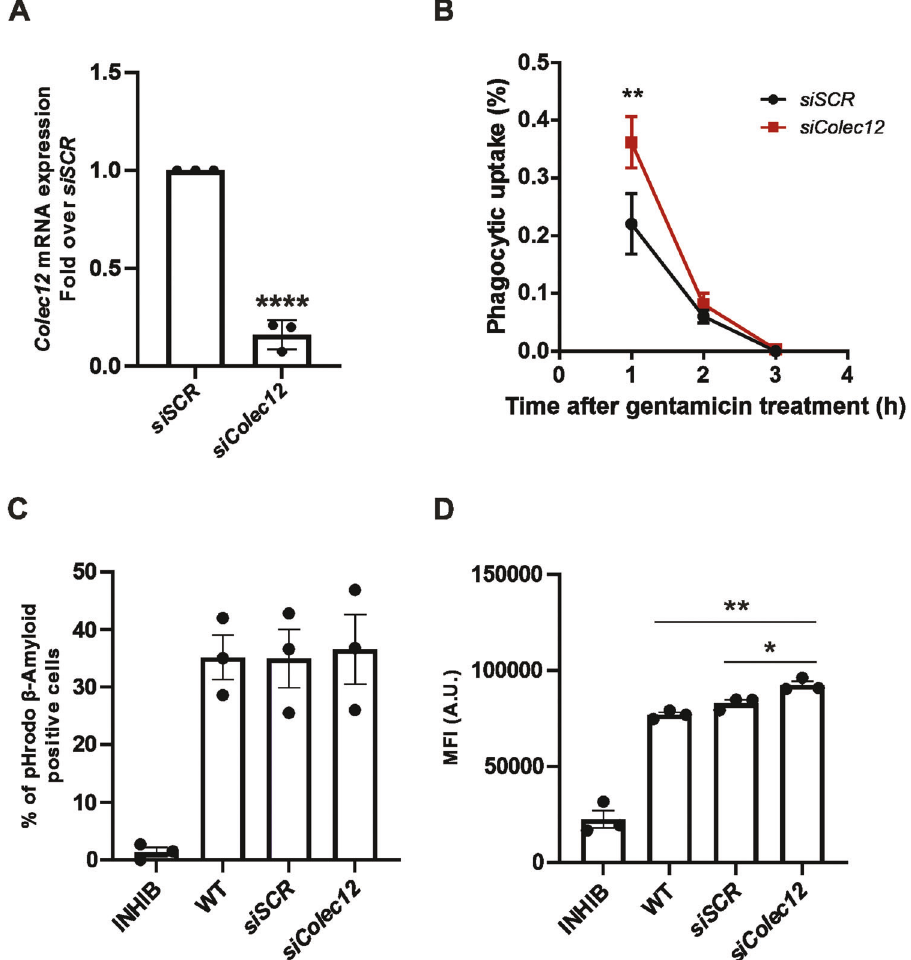
or siSCR used as control at different time points after gentamicin addition. A β phagocytosis capacity of BV2 cells transfected with si Colec12 or Scramble ( siSCR ) used as control represented by the percentage of microglia cells positive for pHrodo stained A β ( C ) or Mean fl uorescence intensity (MFI) ( D ). Statistics were performed with unpaired t-test ( A and D ) or a 2-way ANOVA ( B ) from 3 ( A , C , and D ) to 5 ( B ) independent experiments ±SEM; single data points are represented as dots. P value: *<0.05; **<0.01;